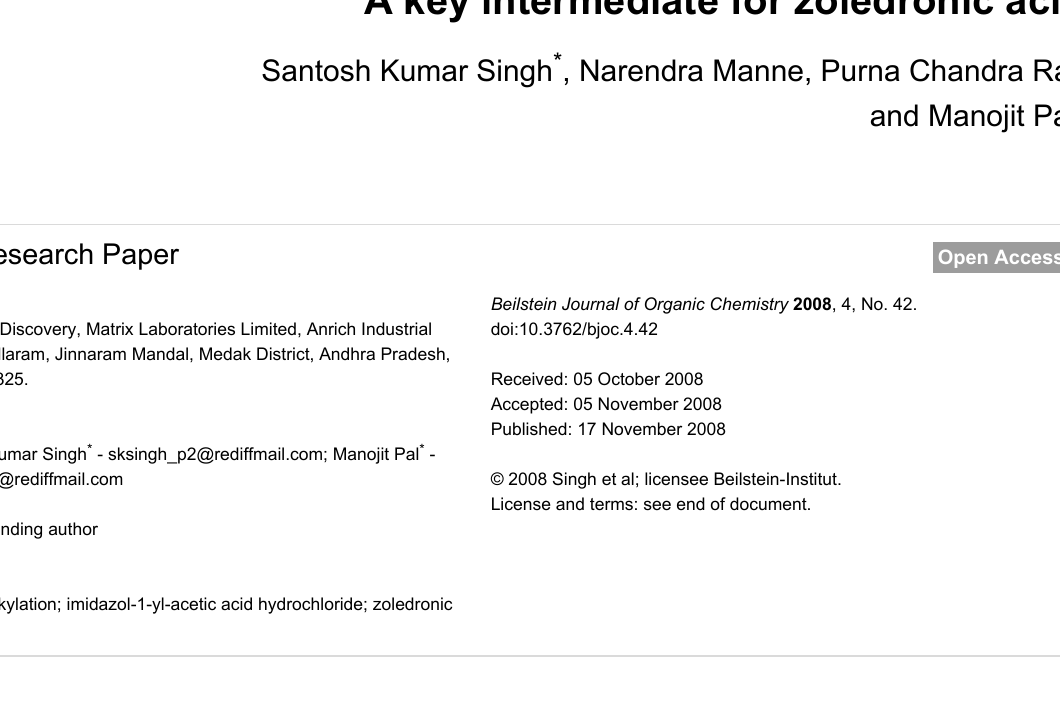
treat bone disease in patients who are suffering from cancer. It of calcium released from the bones into the blood. It is